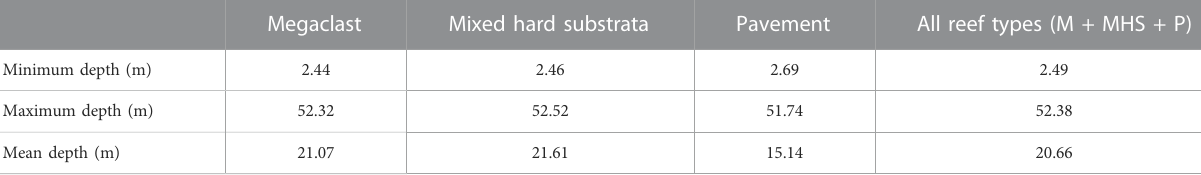
TABLE 3 Depth summaries of hard substratum types (sand excluded).